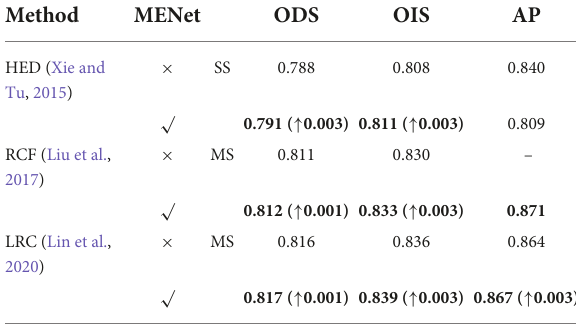
TABLE 1 Comparison of results of other models before and after combining modulation-enhancement network (MENet) on BSDS500 data set.